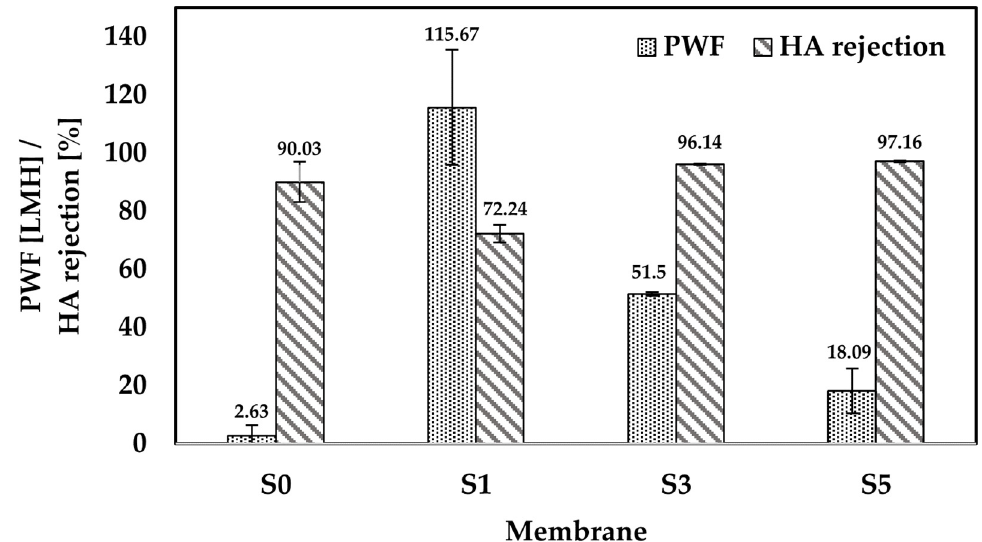
Figure 9. Performance tests in terms of ( a ) PWF and ( b ) HA rejection for the pristine PES membrane without any pore former (S0) and the composite membranes S1, S3, and S5 after 1 h filtration time. Further reductions in PWF were recorded at 5 wt.% MCC loading. The high viscosity casting solution, i.e., 25,000 cP, of the composite membrane S5 (Figure 4 ) led to the for-